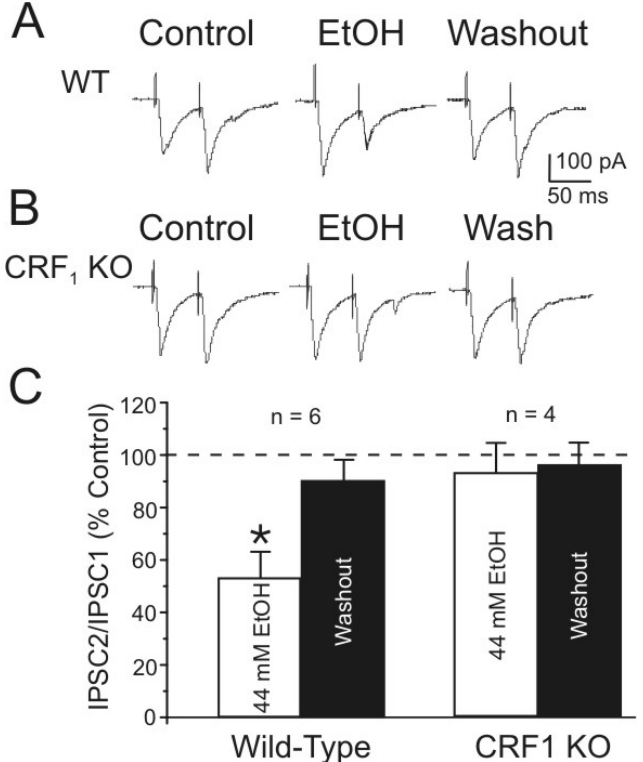
FIGURE 5. Ethanol decreases the PPF of evoked GABA A IPSCs (paired- pulse IPSCs evoked with interstimulus intervals of 50 msec) in CeA neurons from WT mice, but does not significantly effect PPF of IPSCs in CeA neurons from CRF 1 KO mice. (A) Representative current records of evoked IPSCs. Superfusion of 44 m M ethanol decreases the paired-pulse ratio of IPSCs (IPSC2 over IPSC1), to become paired-pulse inhibition, in a CeA neuron from a WT mouse, with recovery on washout. (B) Current records of evoked IPSCs: In a CeA neuron from a CRF 1 KO mouse, superfusion of 44 m M ethanol has little effect on the PPF of evoked IPSCs. (C) Pooled data comparing the effect of 44 m M ethanol on mean paired-pulse ratios of IPSCs from WT and CRF 1 KO mice. Ratios are expressed as percent of mean baseline value (100%). Ethanol 44 m M significantly decreased the mean PPF of IPSCs from WT mice, but had no significant effect on the PPF of evoked IPSCs from CRF 1 KO mice. * = statistical significance at p < 0.05 via